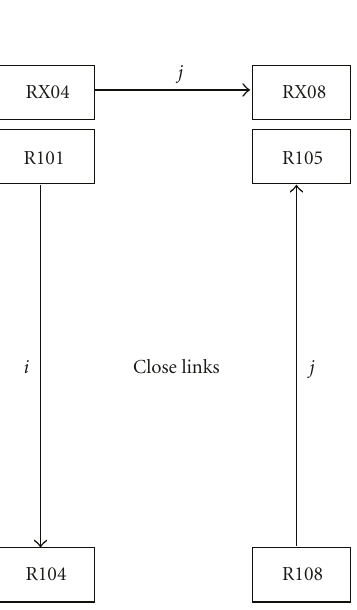
Figure 11: Far links (top) and close links (bottom) scenarios.